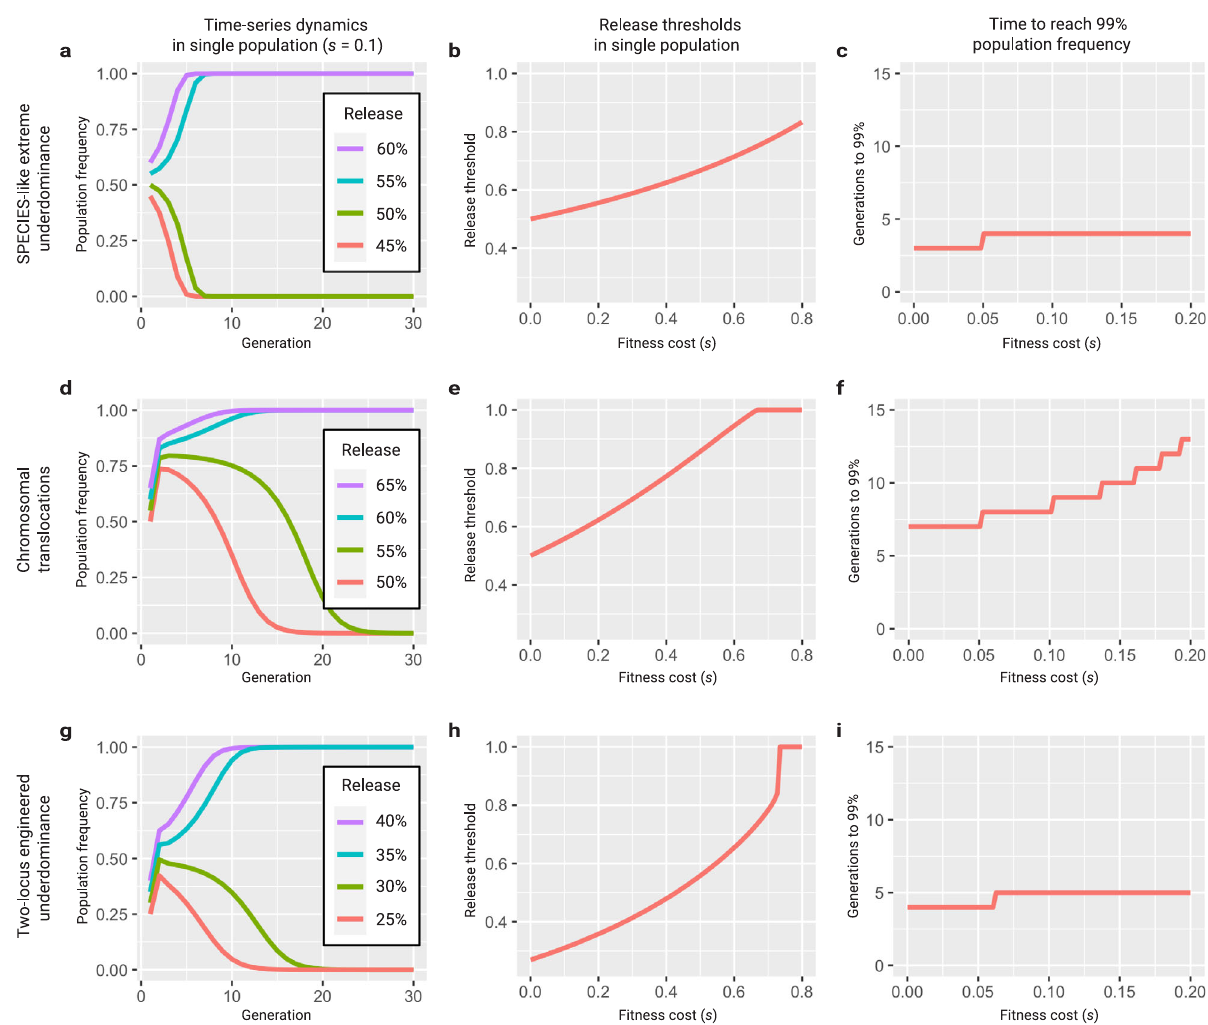
Fig. 5 Population dynamics of underdominant systems in a single population. a Discrete generation model of a SPECIES-like extreme underdominant system with a fi tness cost of 10% released at population frequencies of 45 – 60%. A release threshold is apparent between 50 and 55% (simulations con fi rm a threshold of 52.8%). b The release threshold increases with fi tness cost, from 50% for no fi tness cost, to 83.3% for an 80% fi tness cost. c Extreme underdominant systems spread quickly, reaching a population frequency of 99% (including heterozygotes and homozygotes) within 3 – 4 generations of a release at a frequency of 65% for fi tness costs between 0 and 20%. d Discrete generation model of reciprocal chromosomal translocations with a fi tness cost of 10% released at population frequencies of 50 – 65%. A release threshold is apparent between 55 and 60% (simulations con fi rm a threshold of 56.1%). e The release threshold increases with fi tness cost, from 50% for no fi tness cost, to 62.4% for a 20% fi tness cost. Translocations cannot spread for fi tness costs greater than 66.3%. f Translocations spread less quickly, reaching a population frequency of 99% (including heterozygotes and homozygotes) within 7 – 13 generations of a release at a frequency of 65% for fi tness costs between 0 and 20%. g Discrete generation model of two-locus engineered underdominance with a fi tness cost of 10% released at population frequencies of 25 – 40%. A release threshold is apparent between 30 and 35% (simulations con fi rm a threshold of 31.2%). h The release threshold increases with fi tness cost, from 26.9% for no fi tness cost, to 35.9% for a 20% fi tness cost. Two-locus engineered underdominance cannot spread for fi tness costs greater than 72.7%. i Two-locus engineered underdominant systems spread slightly less quickly, reaching a population frequency of 99% (including heterozygotes and homozygotes) within 4 – 5 generations of a release at a frequency of 65% for fi tness costs between 0 and